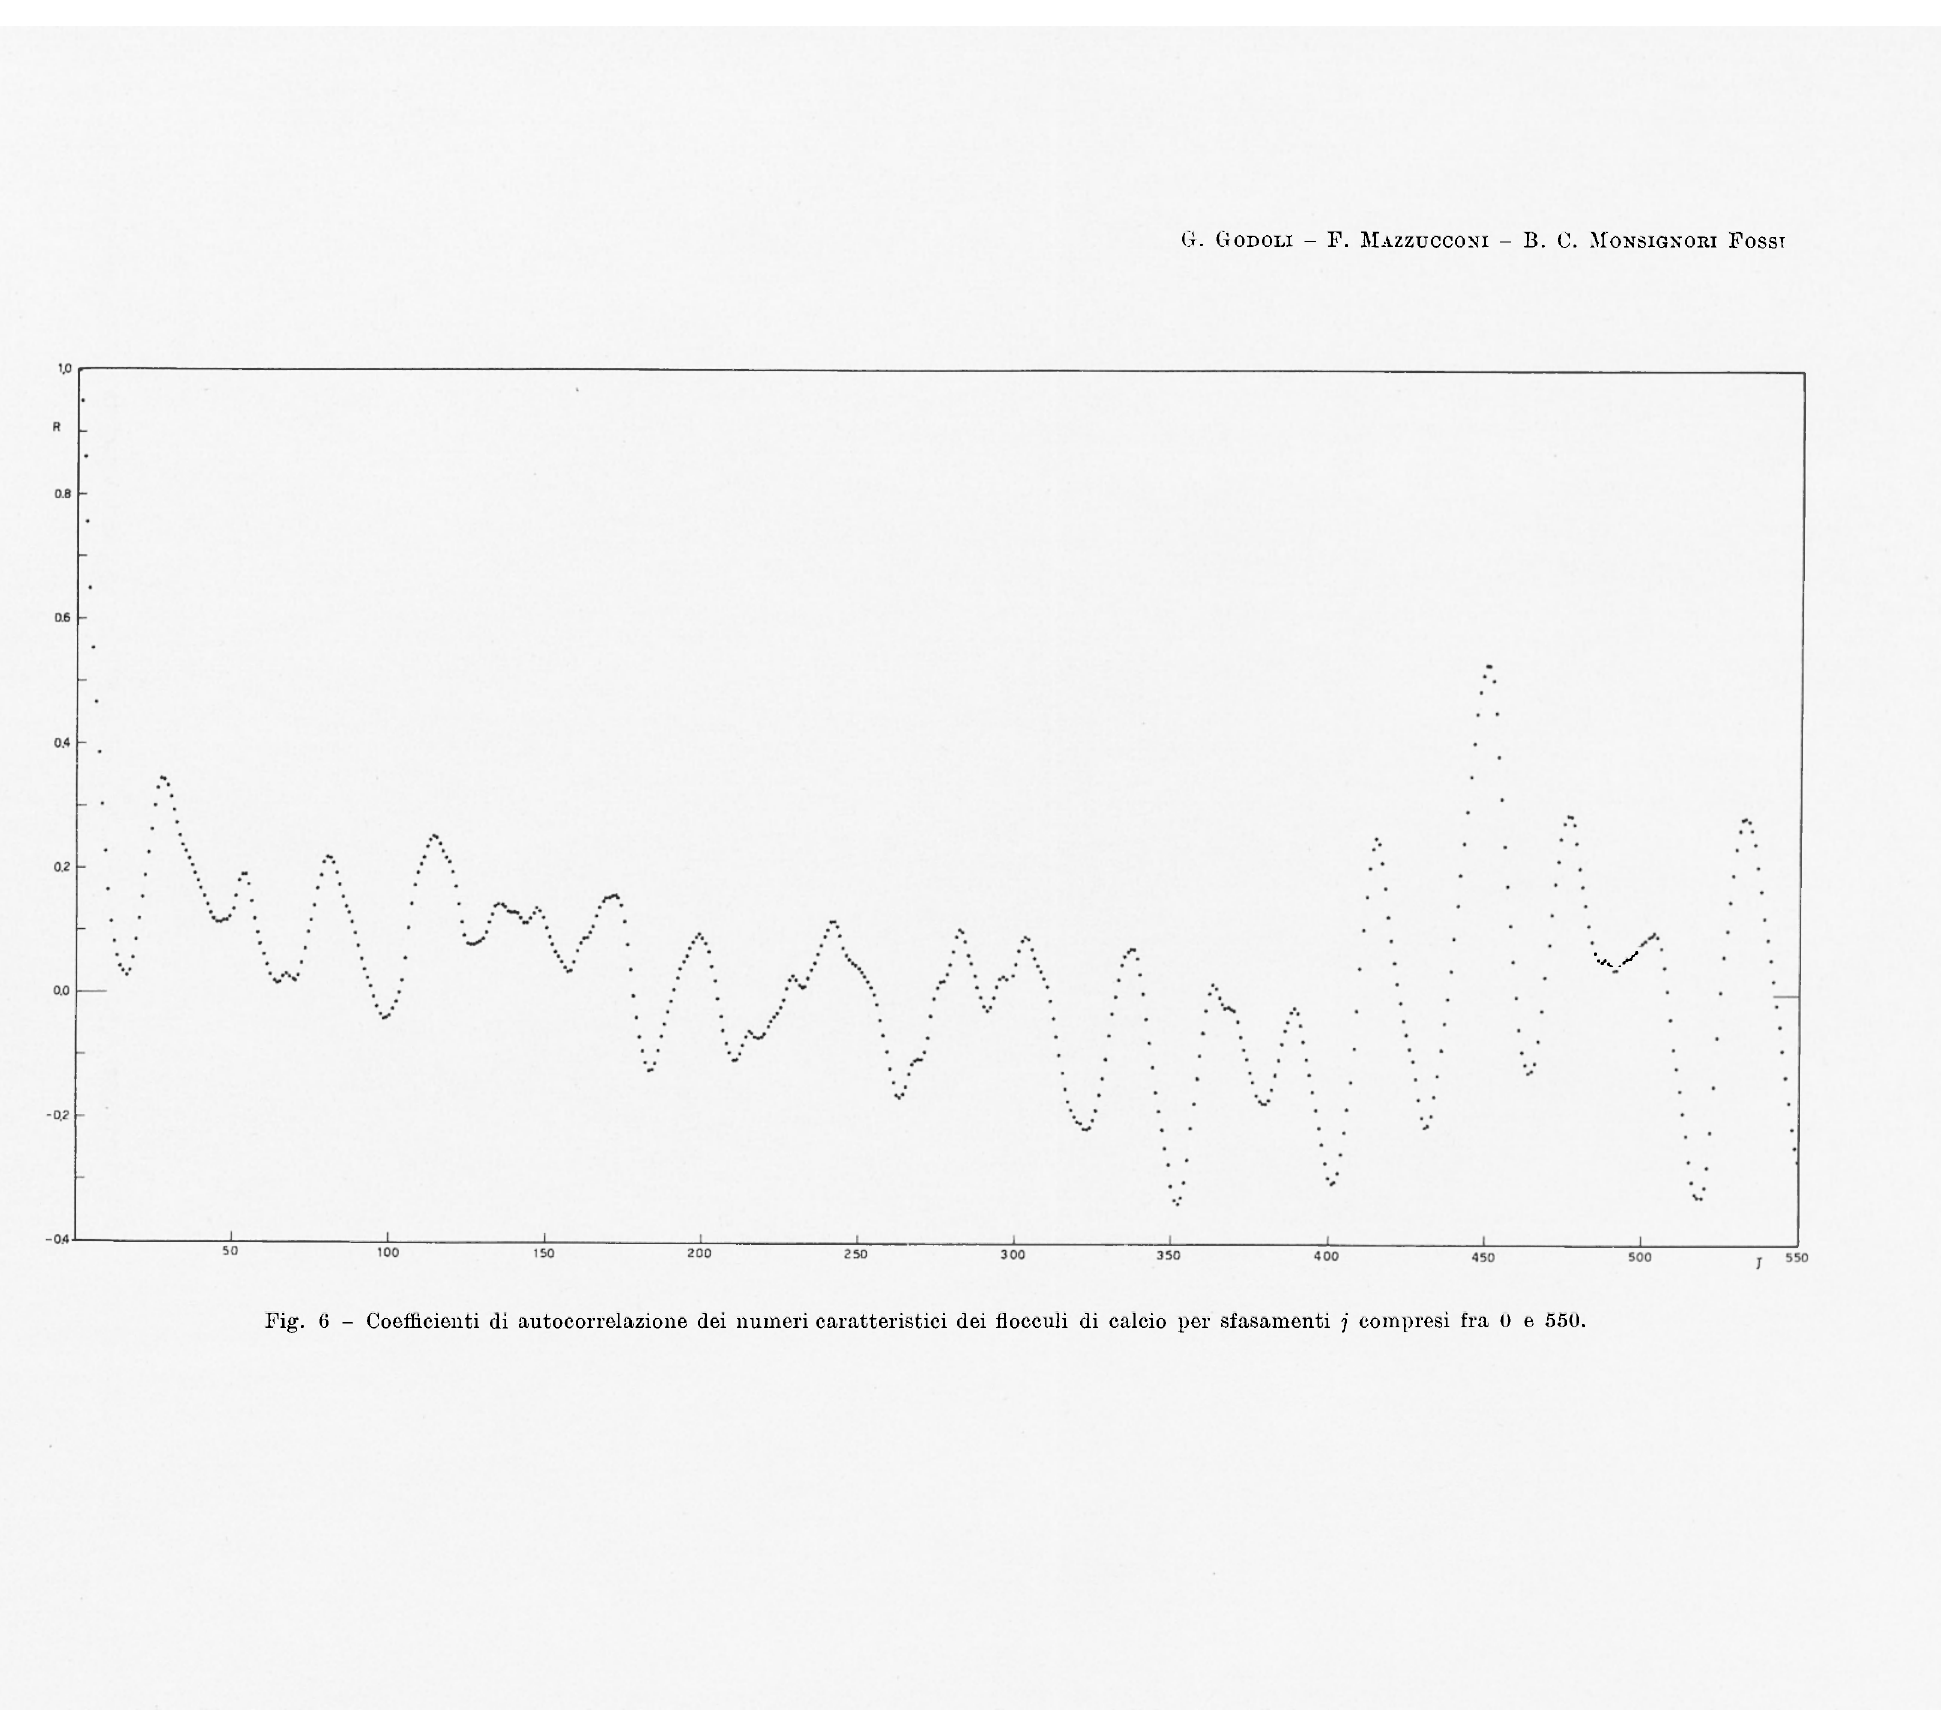
Pig. 6 - Coefficienti di autocorrelazione dei numeri caratteristici dei flocculi di calcio per sfasamenti j compresi fra 0 e